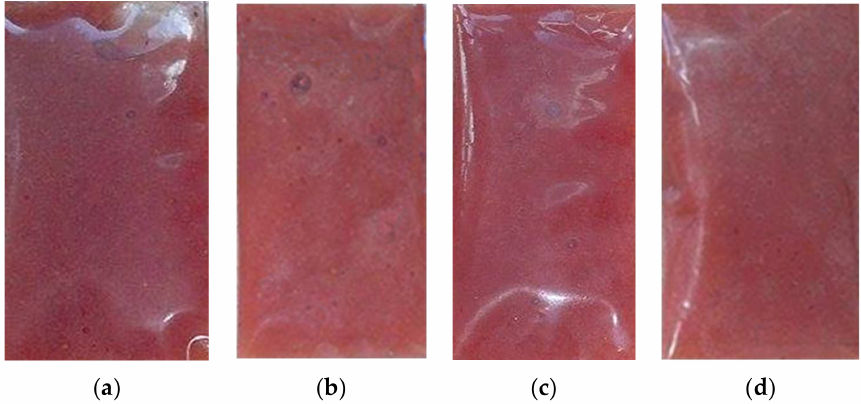
Figure 5. Color estimation of ( a ) control (raw); ( b ) TT; ( c ) HPP; ( d ) HPMT sample.